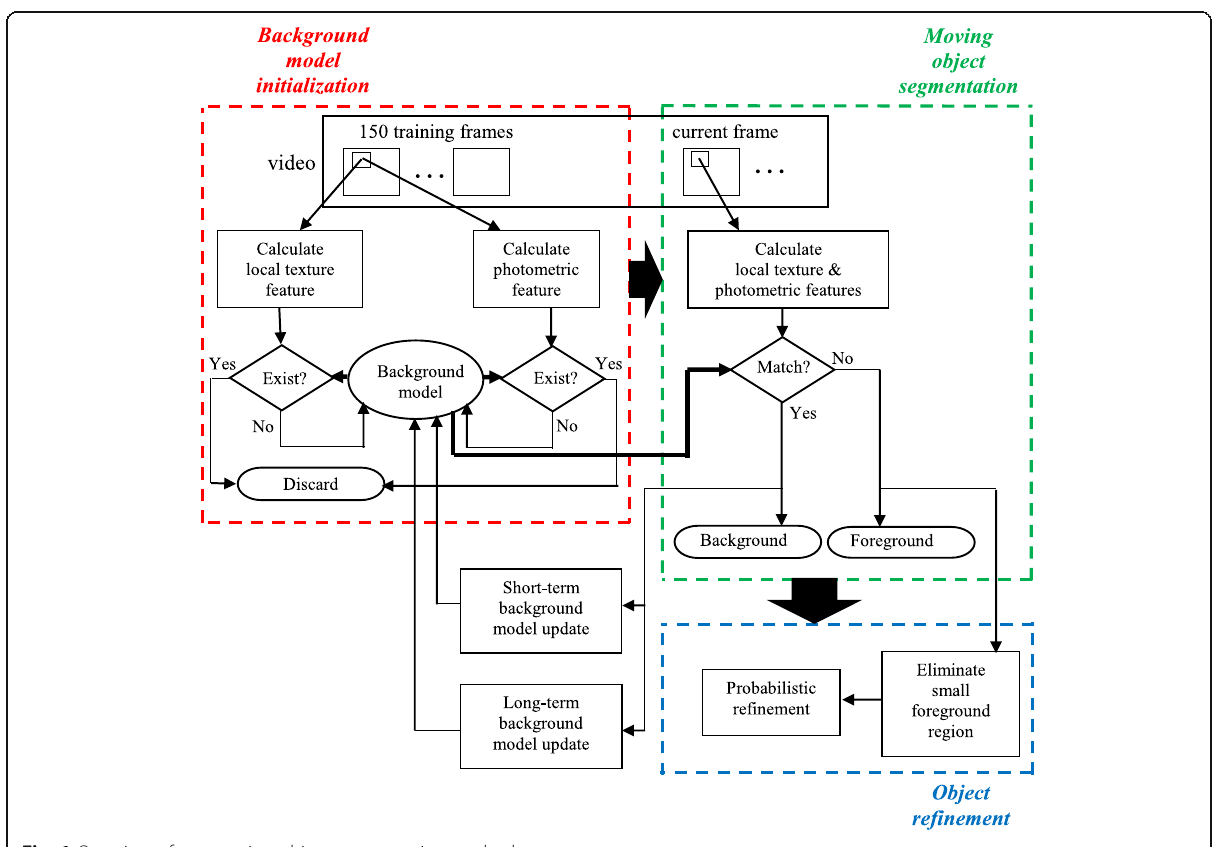
Fig. 1 Overview of our moving object segmentation